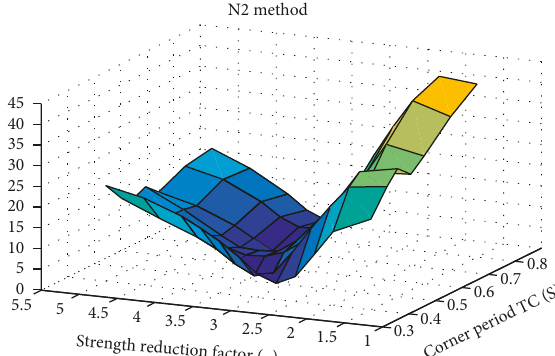
Figure 11: Overall results for the N2 method. The global average discrepancy values are plotted in 3D ( z -axis) with respect to the strength reduction factor values ( R ) in y -axis and upper corner period of the plateau ( T C ) in x -axis. A minimum “valley” appears for R values around R 3 . (cid:31)